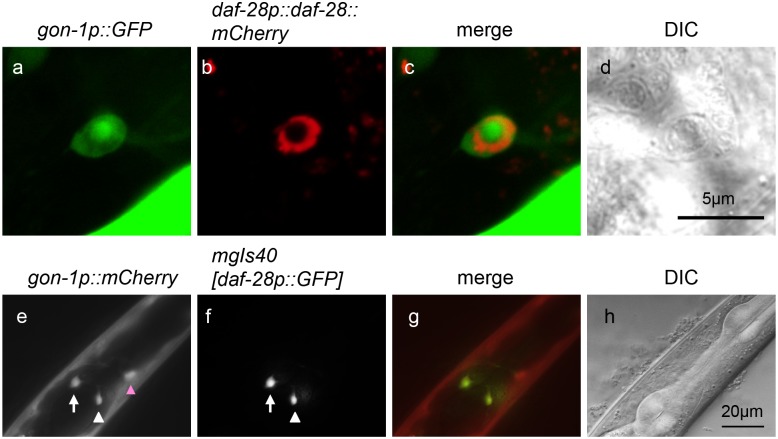
GON-1 and DAF-28 are expressed in the same cells.(a, b) Representative fluorescent images of a gon-1(tm3146) mutant animal co-expressing gon-1p::GFP (a) and daf-28p::daf-28::mCherry (b). (c) The merged image. (d) The DIC image of the same field shown in (a-c). The scale bar indicates 5 μm. (e, f) Representative fluorescent images of gon-1p::mCherry (e) and mgIs40[daf-28p::GFP] (f). (g) The merged image. (h) The DIC image of the same field shown in the (e-g). The scale bar indicates 20 μm. The white arrowhead indicates an ASI neuron. The white arrow indicates an ASJ neuron. The pink arrowhead indicates an unidentified neuron.